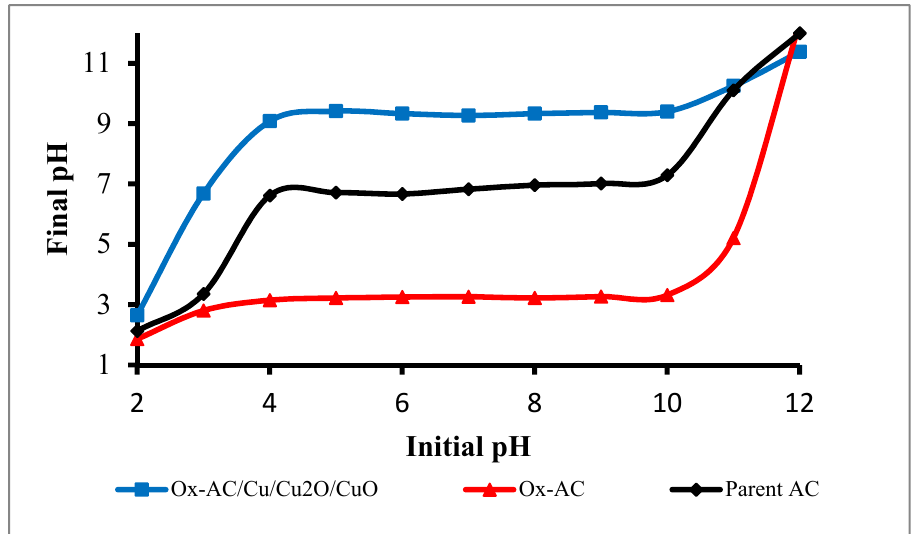
Figure 6. Point of zero charge for parent AC, Ox-AC and Ox-AC/CuO.